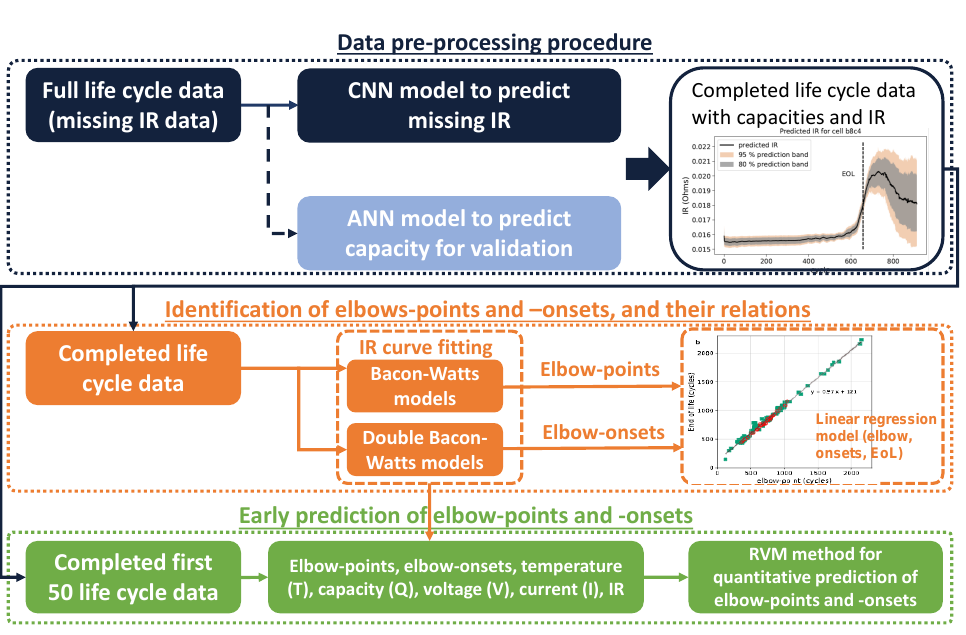
Figure 3. Graphical abstract for the proposed algorithmic